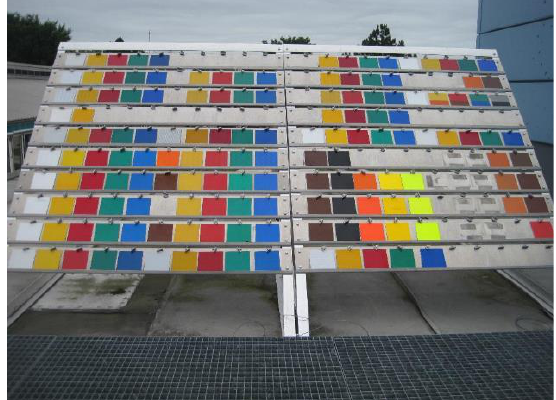
Figure 3. Reflective sheeting samples in the NMF data.